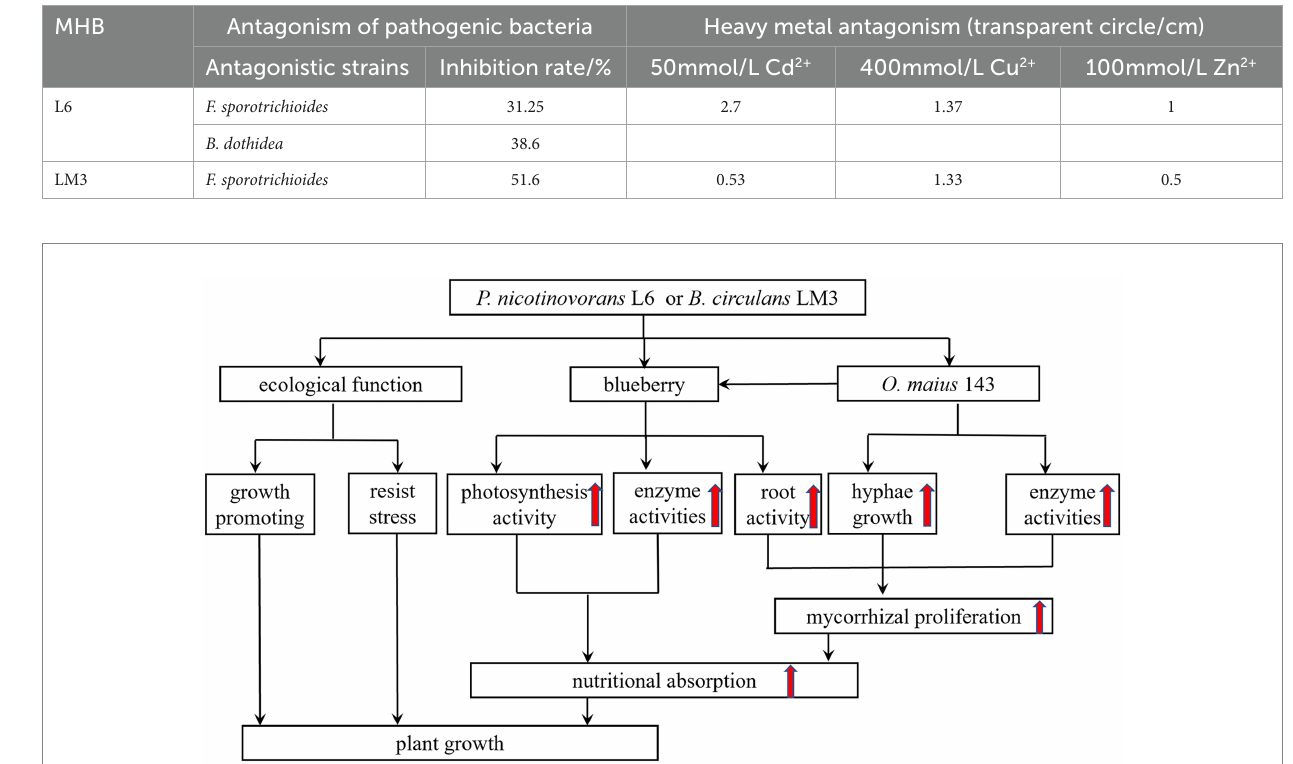
FIGURE 6 A proposed model illustrating the mechanism through which mycorrhizal helper bacterium P. nicotinovorans L6 or B. circulans LM3 improve the growth of